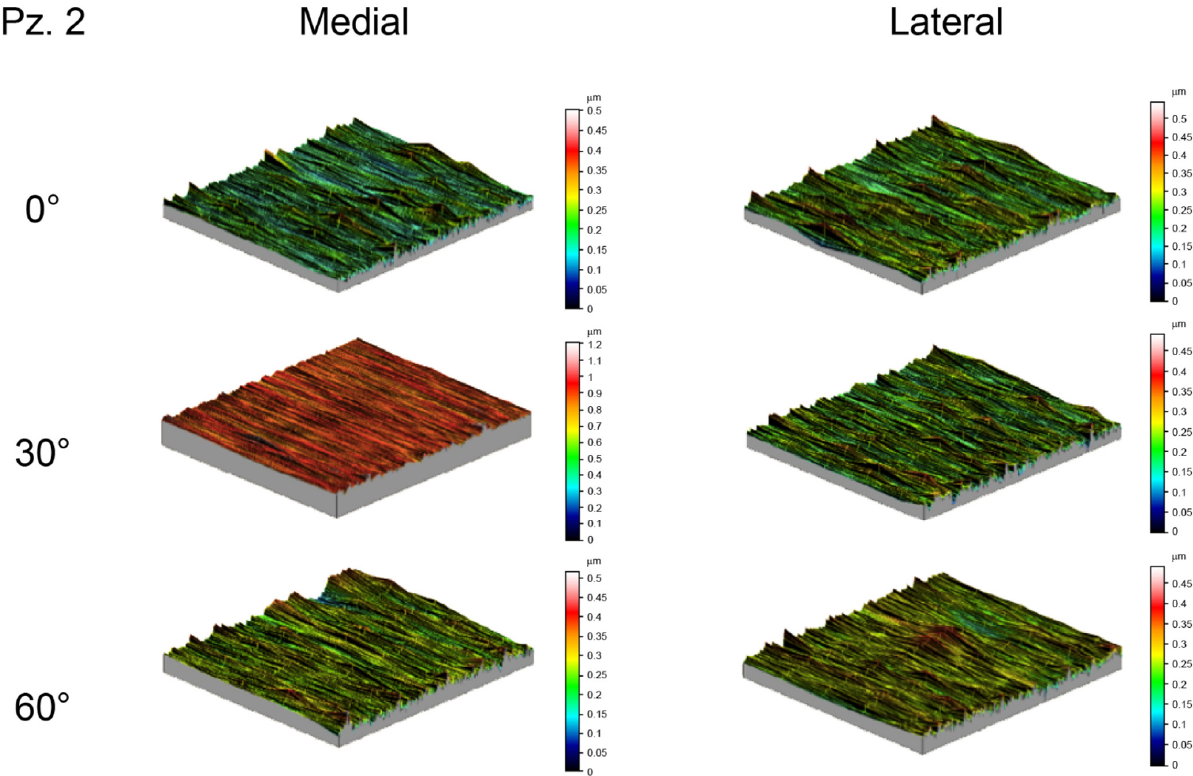
Figure 2. Topographical picture of the medial and lateral condyle with the lowest Ra value.